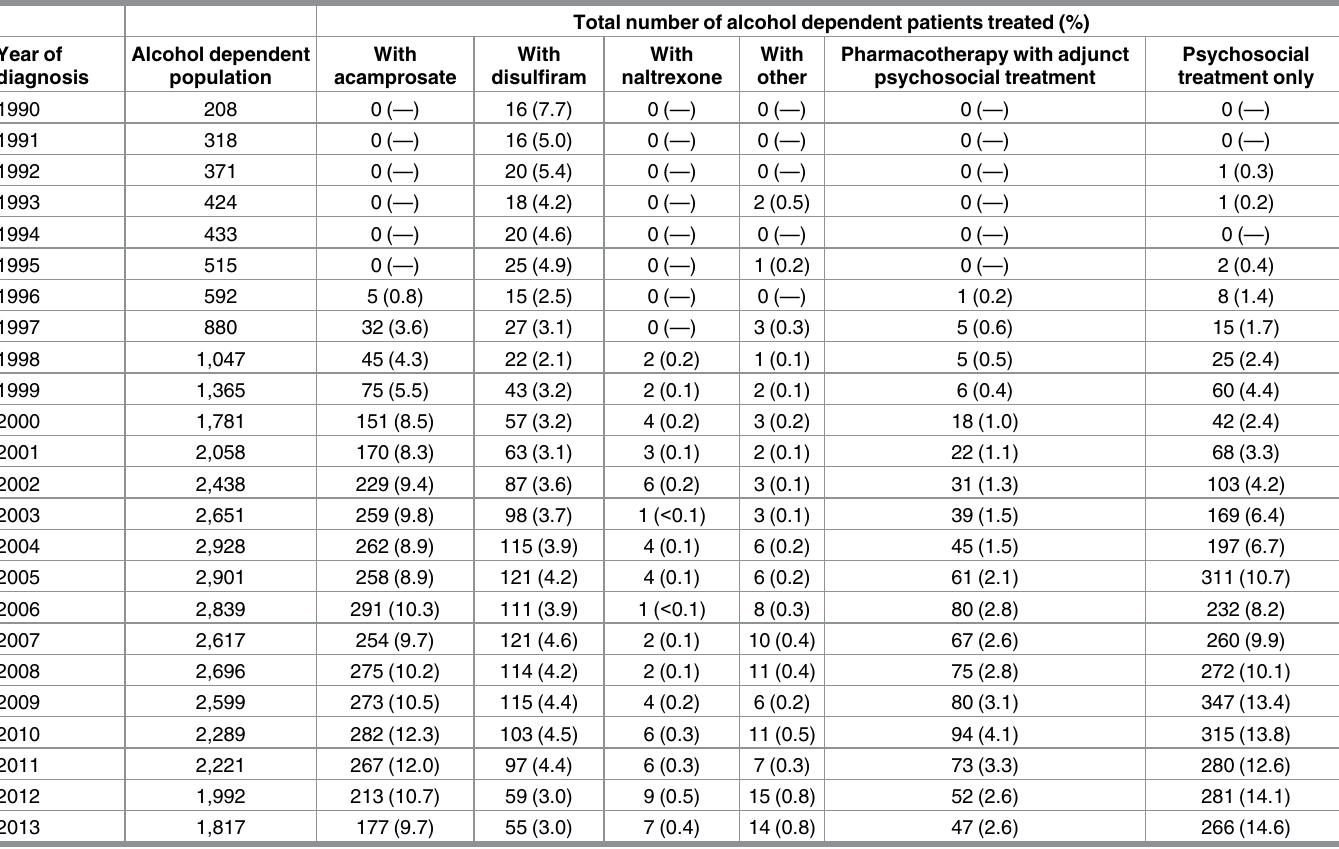
Table 2. Alcohol dependence cohort, number of patients treated with pharmacotherapies and number of patients receiving psychosocial support, by calendar year. Total number of alcohol dependent patients treated